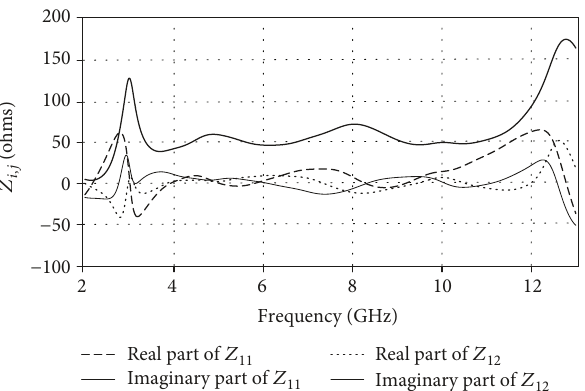
Figure 7: Simulated input impedance of the proposed MIMO